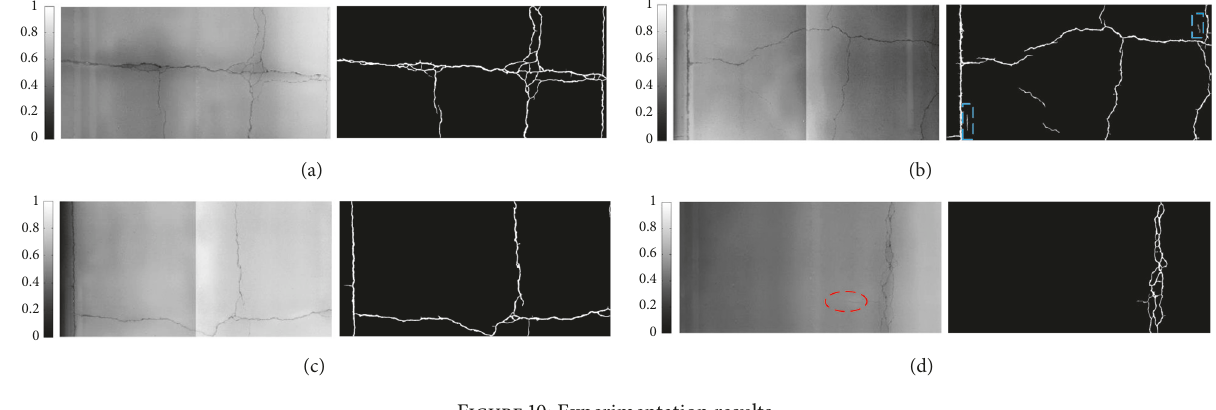
Figure 10: Experimentation results. Table 2: Performance comparison of different methods.